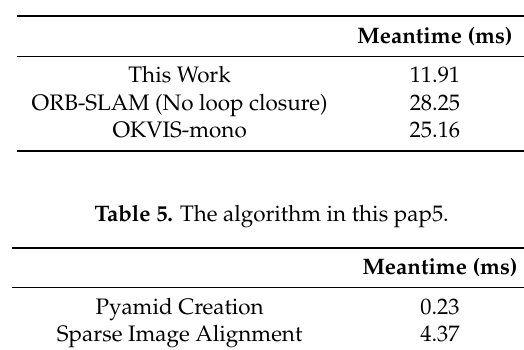
Table 4. The mean time to process a camera frame on a hardware platform using the Intel Core i5-7500 CPU (3.4 GHz × 4).